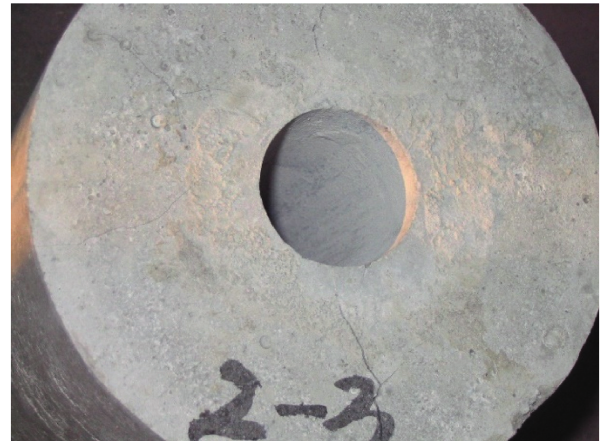
Figure 7: Surface statuses of the borehole of the splitting failure